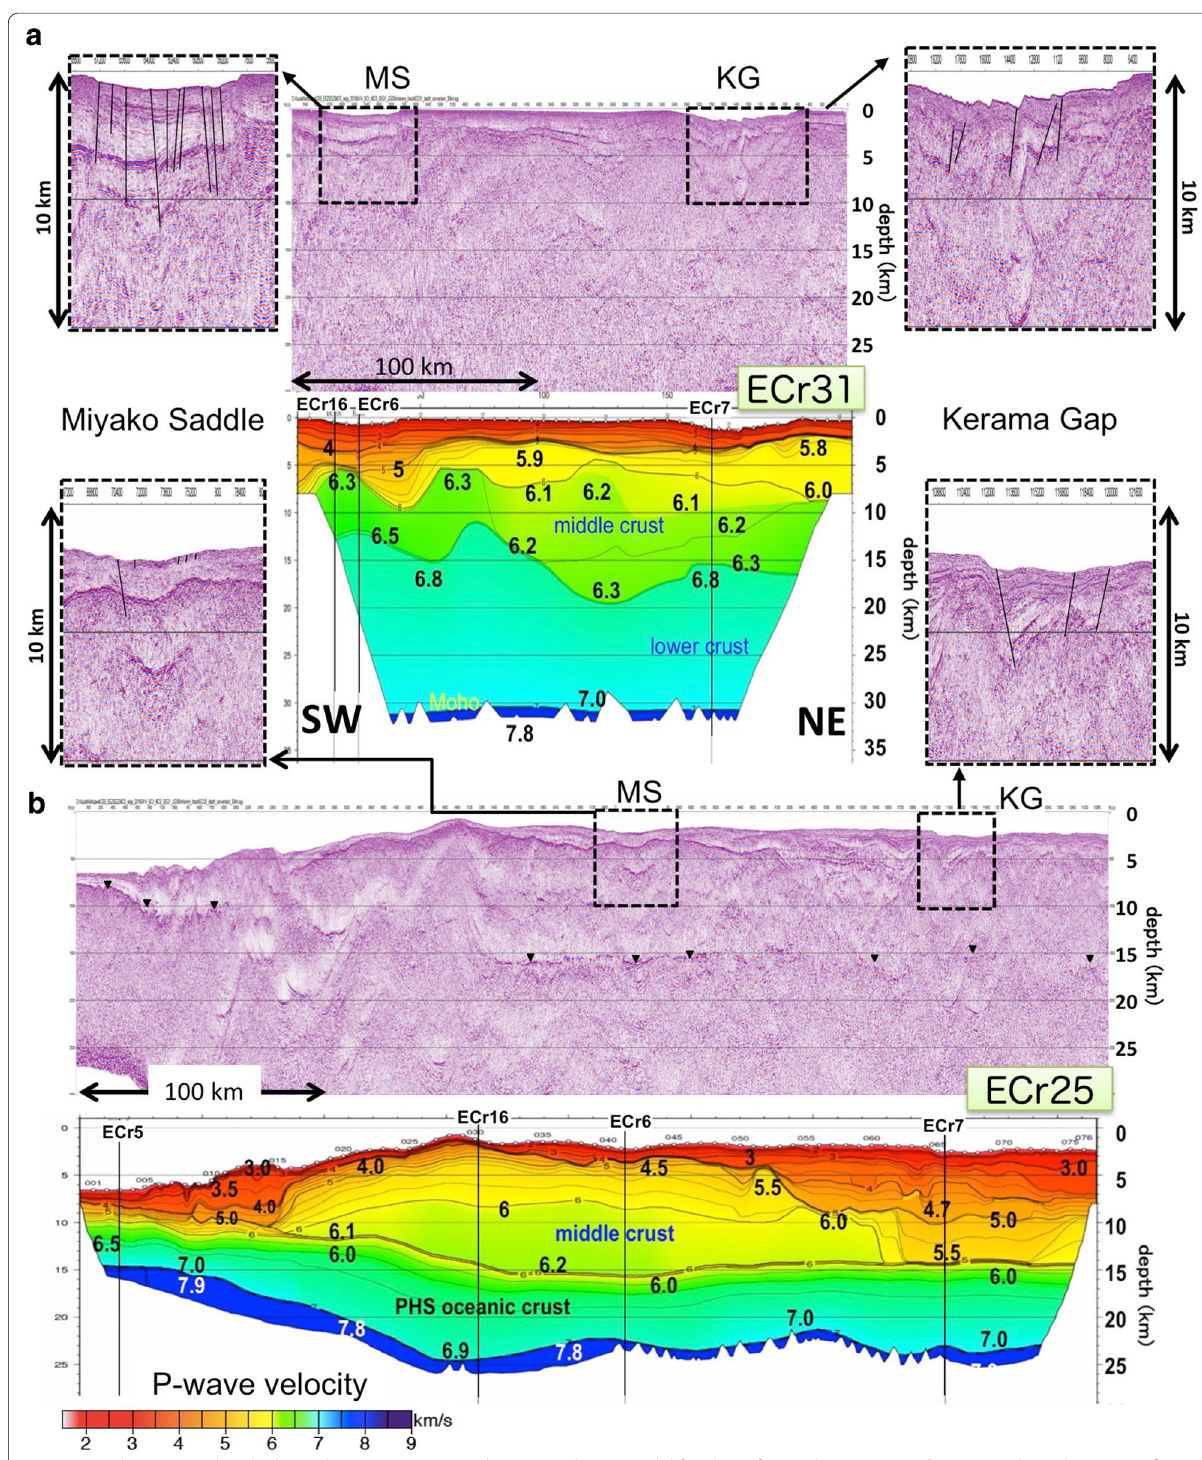
Fig. 7 Depth-converted multichannel seismic section and P -wave velocity model for along-forearc lines. a ECr31, b ECr25. Enlarged seismic reflec- tion images with interpretation for the Kerama Gap and the Miyako Saddle are also shown. The black lines in the interpretation indicate steeply dipping normal